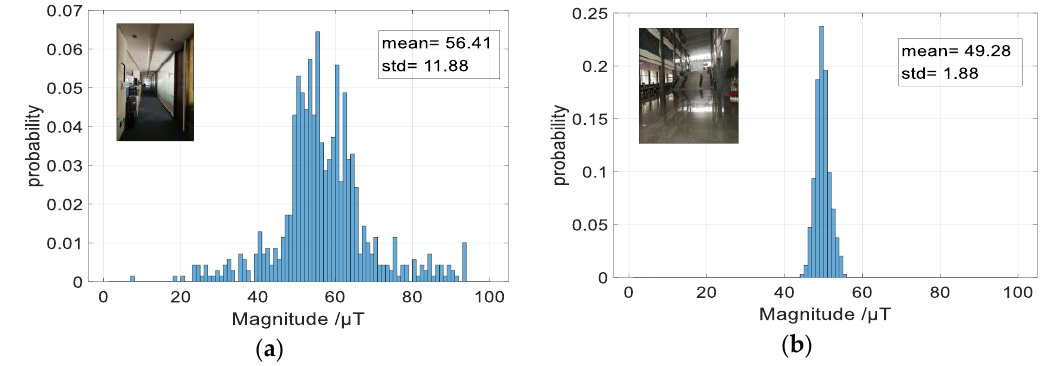
Figure 6. Static magnetometer measurement distribution of different scenarios by the same smartphone. ( a ) corridor; ( b ) large open-plan area.